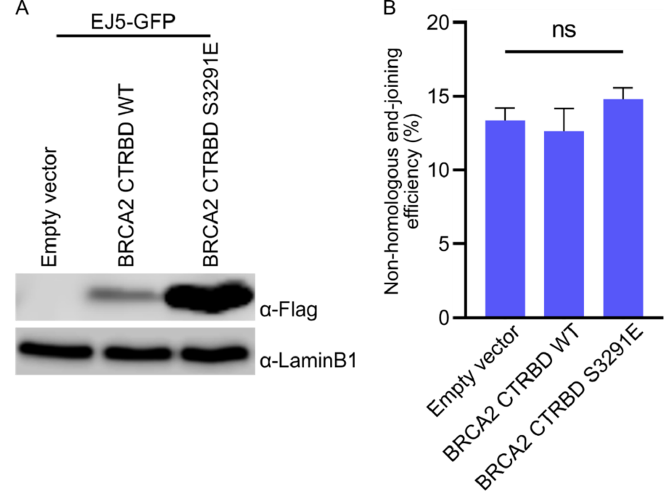
Figure 5. Expression of the CTRBD did not influence nonhomologous end-joining efficiency. ( A ) Expression of the exogenous FLAG-HA-fused BRCA2 CTRBD (3260–3331 aa) and its mutant (S3291E) was evaluated using Western blotting. ( B ) Nonhomologous end-joining efficiency was assessed using GFP-based assays. The transfection efficiency was normalized by the cotransfected mCherry-expressing vector. Significance was examined by one-way ANOVA with Tukey’s HSD multiple comparison test. The error bars indicate the standard deviation ( n = 3). ns: non-significant difference in each control group.